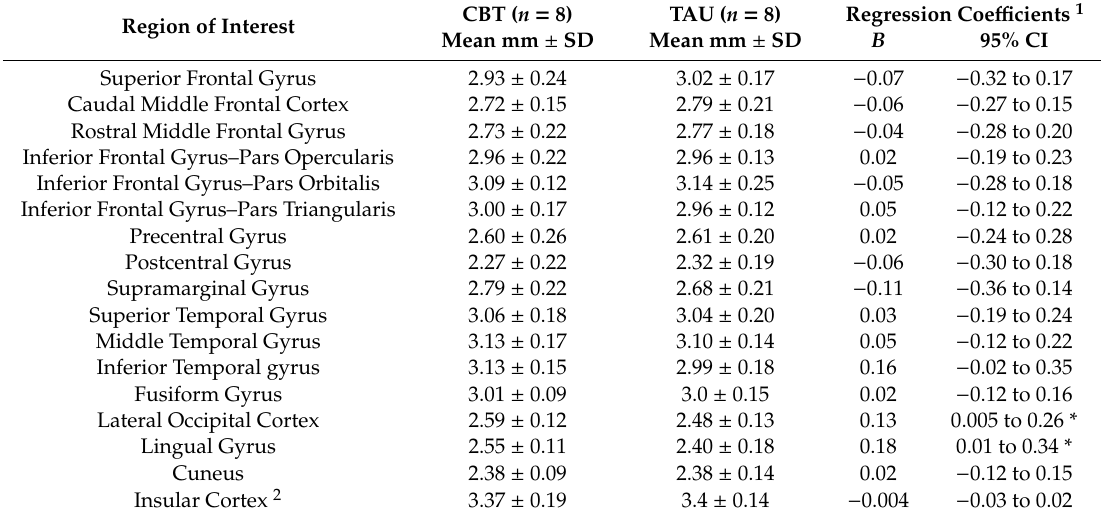
Table 3. Average Magnetic Resonance Imaging (MRI)-derived local gray matter thickness di ff erences in the right hemisphere in children aged approximately six years in a longitudinal study, built on a pilot Randomized Controlled Trial comparing Cognitive Behavioral Therapy (CBT) and Treatment as Usual (TAU) for maternal antenatal depression.